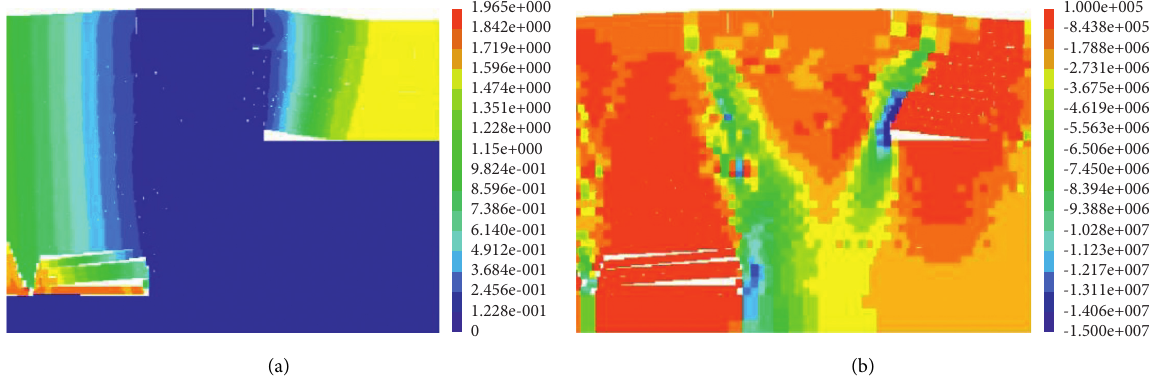
Figure 9: Evolution of displacement and stress in coal seam mining for the case where the lower coal seam is excavated with the coal face 20m from the boundary pillar of the goaf. (a) Nephogram of stope displacement. (b) Vertical stress cloud map of stope.